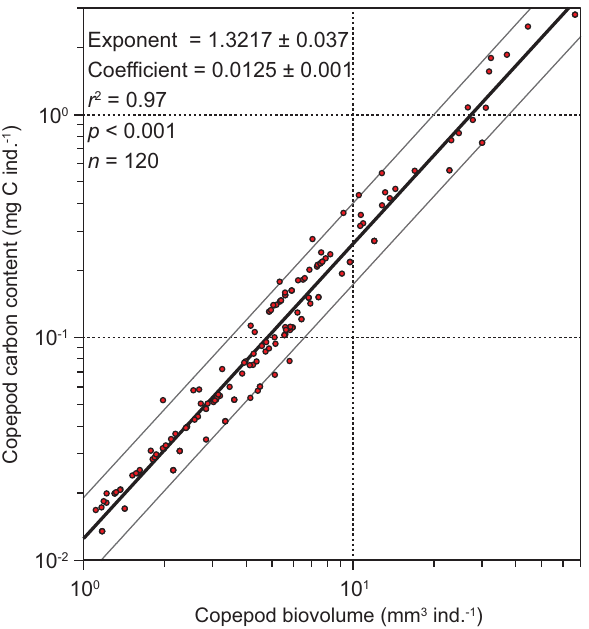
Fig. 11. Regression of the empirical carbon content of each stage of each Arctic copepod species in the size range 1–6mm (equivalent spherical diameter) present in the Beaufort Sea against its biovol- ume as estimated with morphometric relationships (see Sect. 4.2 for related discussion). This regression aims at providing a spe- cific biovolume-to-carbon conversion factor (power-law equation ( y = ax k ) where ( a) is the multiplier coefficient and ( k) is the scal- ing exponent) for large Arctic copepods in order to estimate most accurately the copepod biomass with the Underwater Vision Profiler 5 in the Beaufort Sea, and in the Arctic Ocean in